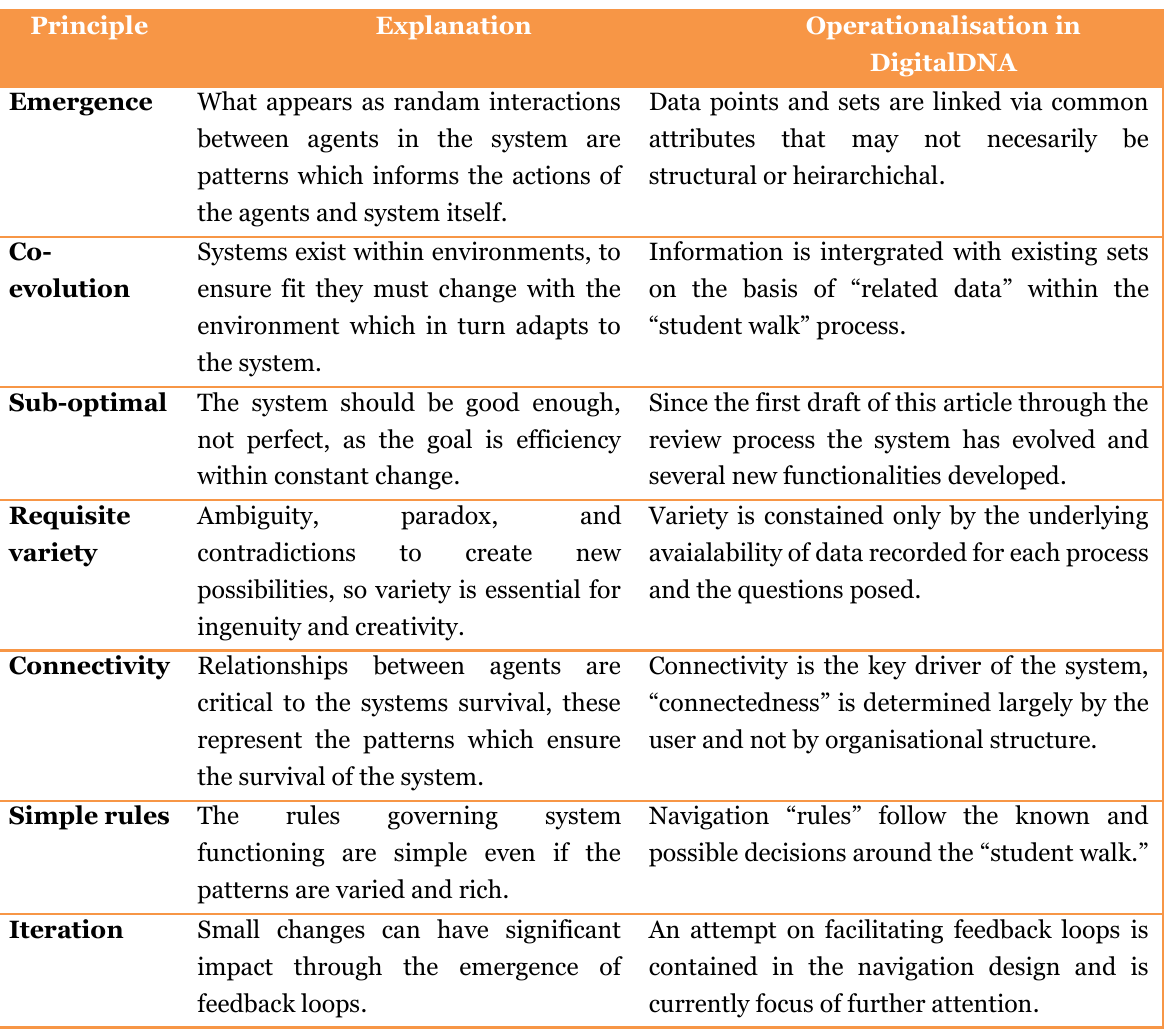
Emergent Charecteristics of Complex Adaptive System Principles Applied to the DigitalDNA